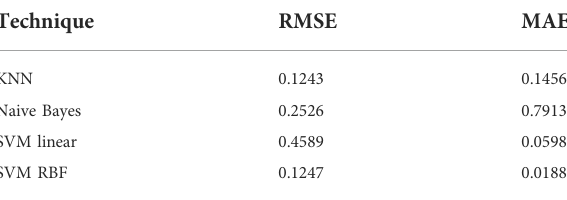
TABLE 2 Result of error measurement using KNN, SVM linear, SVM RBF, and naïve Bayes. Technique